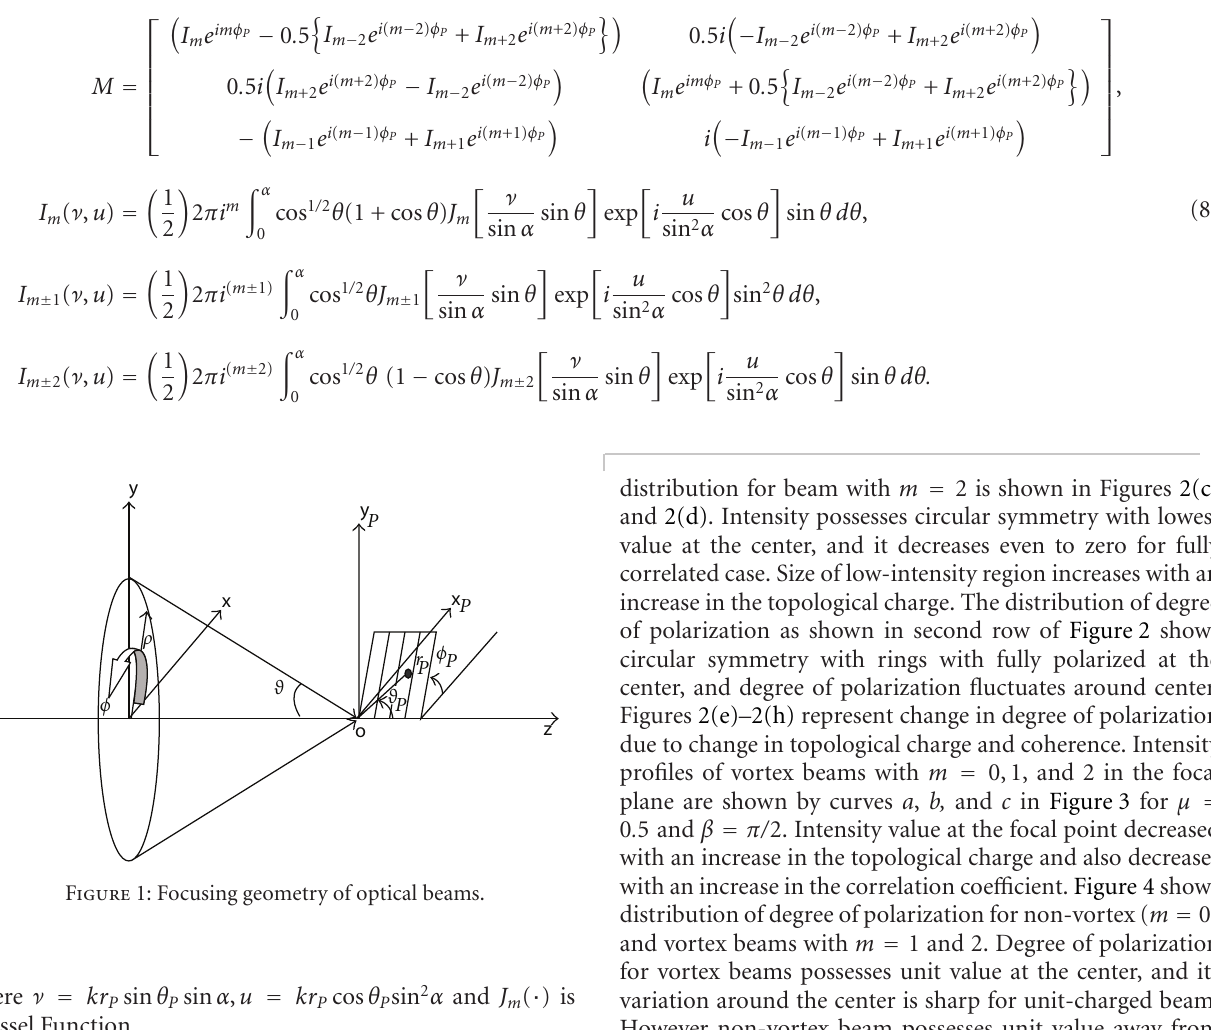
Here ν = kr P sin θ P sin α , u = kr P cos θ P sin 2 α and J m ( · ) is Bessel